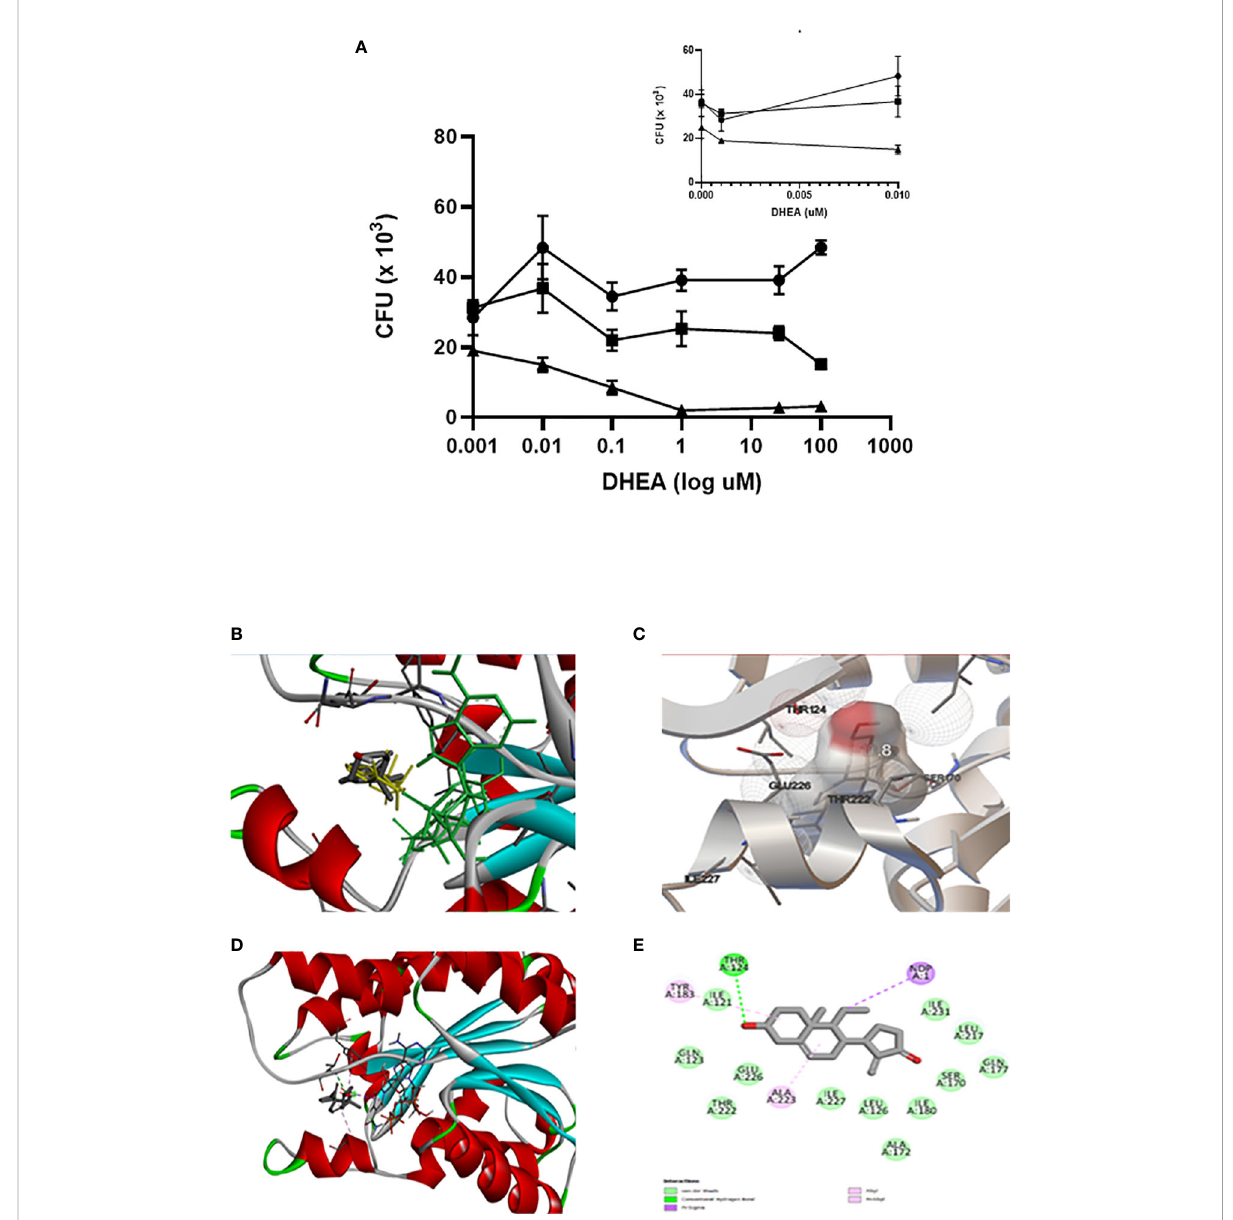
FIGURE 5 DHEA interacts with 11 b -HSD 1 occupying the active site as its natural substrate corticosterone. The effect of DHEA on the killing of Mtb by macrophages is DHEA dose-dependent. Incubations time of macrophages with DHEA. (- ● - T = 1, - ■ - T = 2, - ▲ - T = 3 days). The insert in the arithmetic scale shows UFC in the absence and presence of the lowest DHEA concentrations (A) . Superimposed analysis by docking between DHEA (gray) and 11 b -HSD1 co-crystalized with corticosterone (yellow) shows that both molecules share the same pose into the binding site of 11 b -HSD1 (B) . Rigid docking simulations performed by Autodock Vina evidence that DHEA interacts with the active site of 11 b -HSD1 establishing a hydrogen bond (C) . Visualization of the active site in the presence of NADH cofactor docked with DHEA (D) . DHEA into the active site of 11 b - HSD1 establishes a hydrogen bond with Thr124 of the enzyme (E)